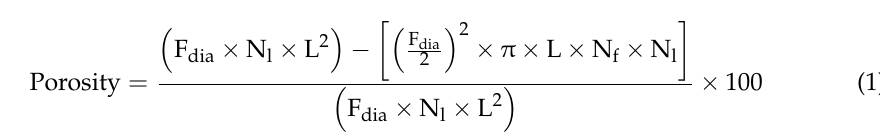
Figure 2. Scaffold configuration: ( a ) top view and ( b ) front view of the scaffold model. ( c ) Indication of filament distance and filament diameter.